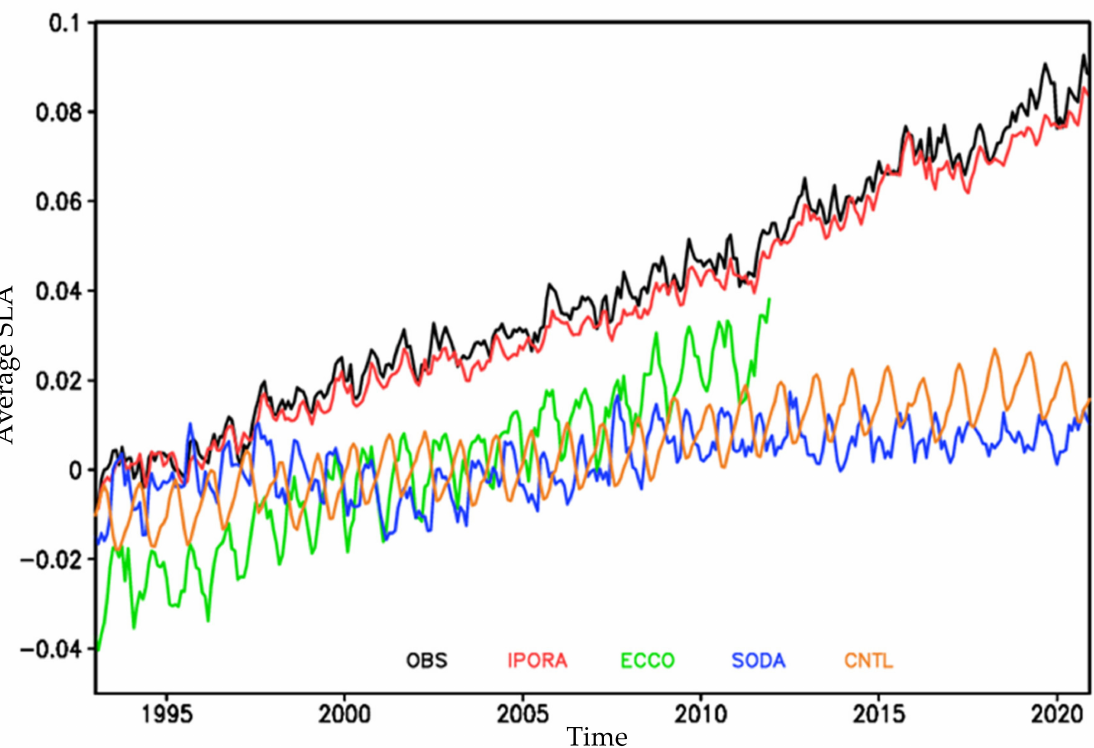
Figure 5. Time series of the average SLA (units: m) from the observations, CNTL, IPORA, ECCO, and SODA in the Indian and Pacific